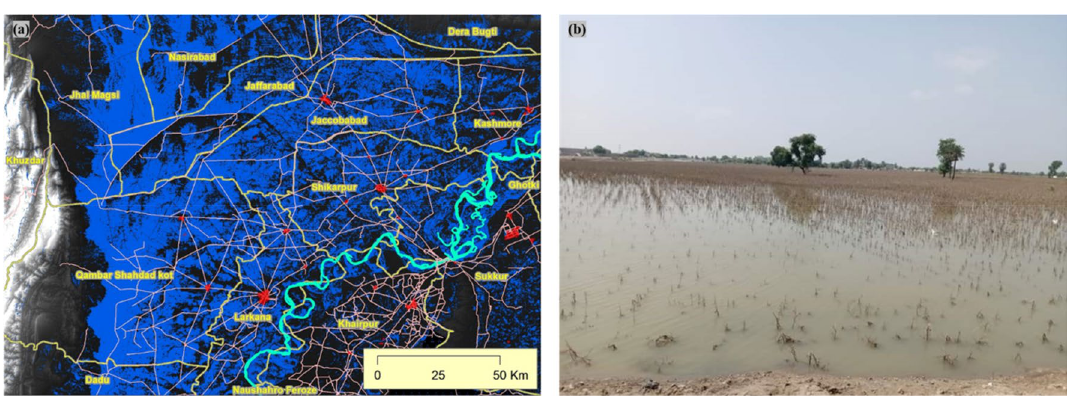
Figure 5. Flood water inundation ( a ) extent and patterns of flood-inundated areas in Jacobabad and Dera Murad Jamali on 28 August 2022 ( b ) ground condition